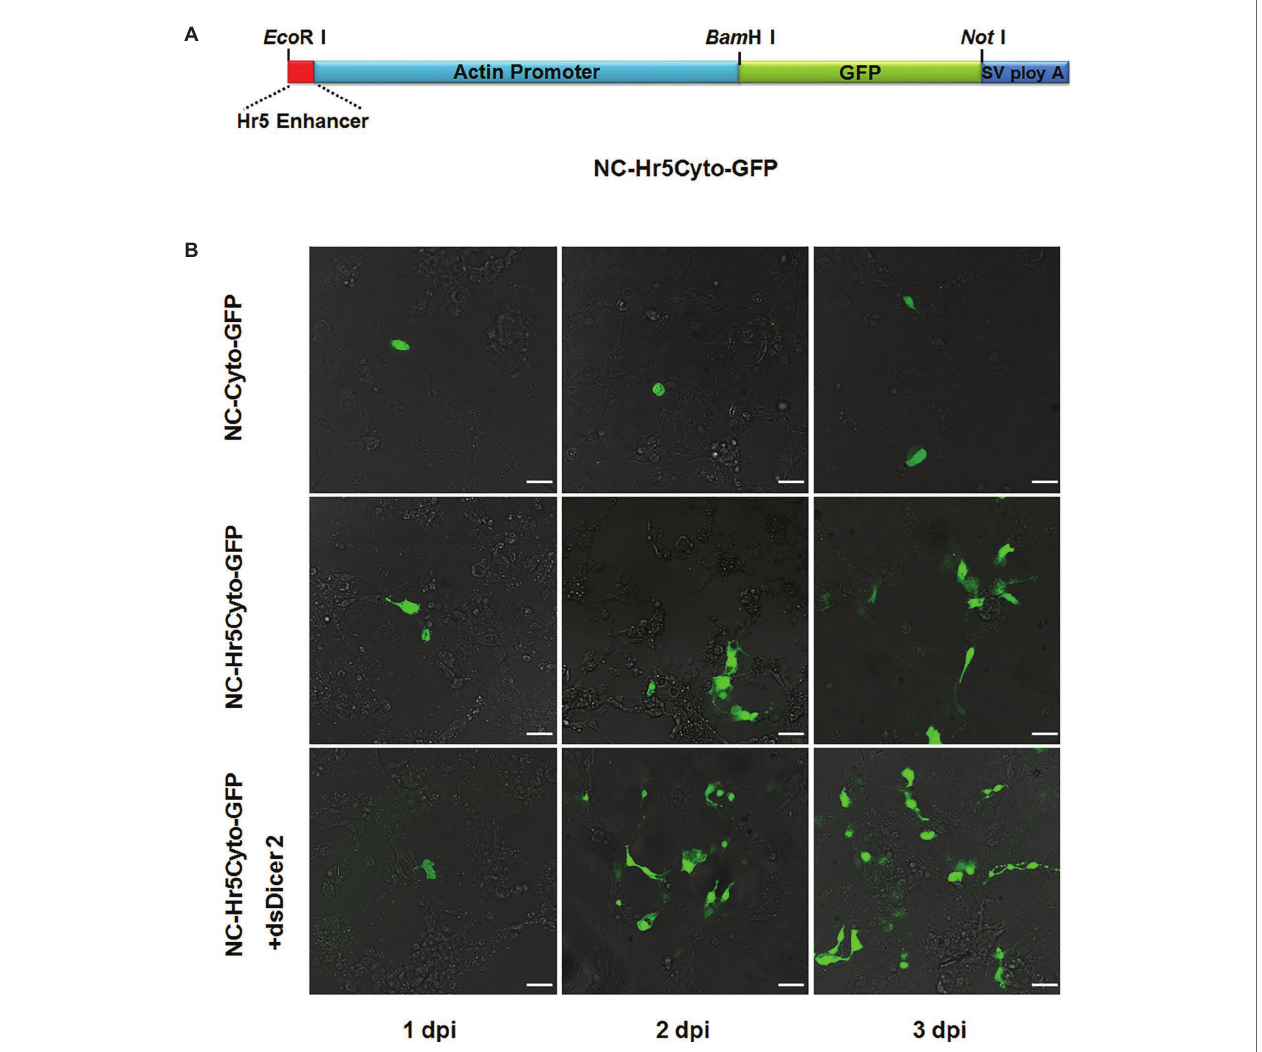
FIGURE 2 | Optimization of N. cincticeps cytoplasmic actin promoter efficiency in N. cincticeps cells. (A) Schematic representations of the NC-Hr5Cyto-GFP construct. (B) Examination of the optimized vector NC-Hr5Cyto-GFP in cultured N. cincticeps cells. Cells transfected with the NC-Cyto-GFP vector were used as a control. dsDicer2 RNA was co-transfected with NC-Hr5Cyto-GFP. Scale bar: 20